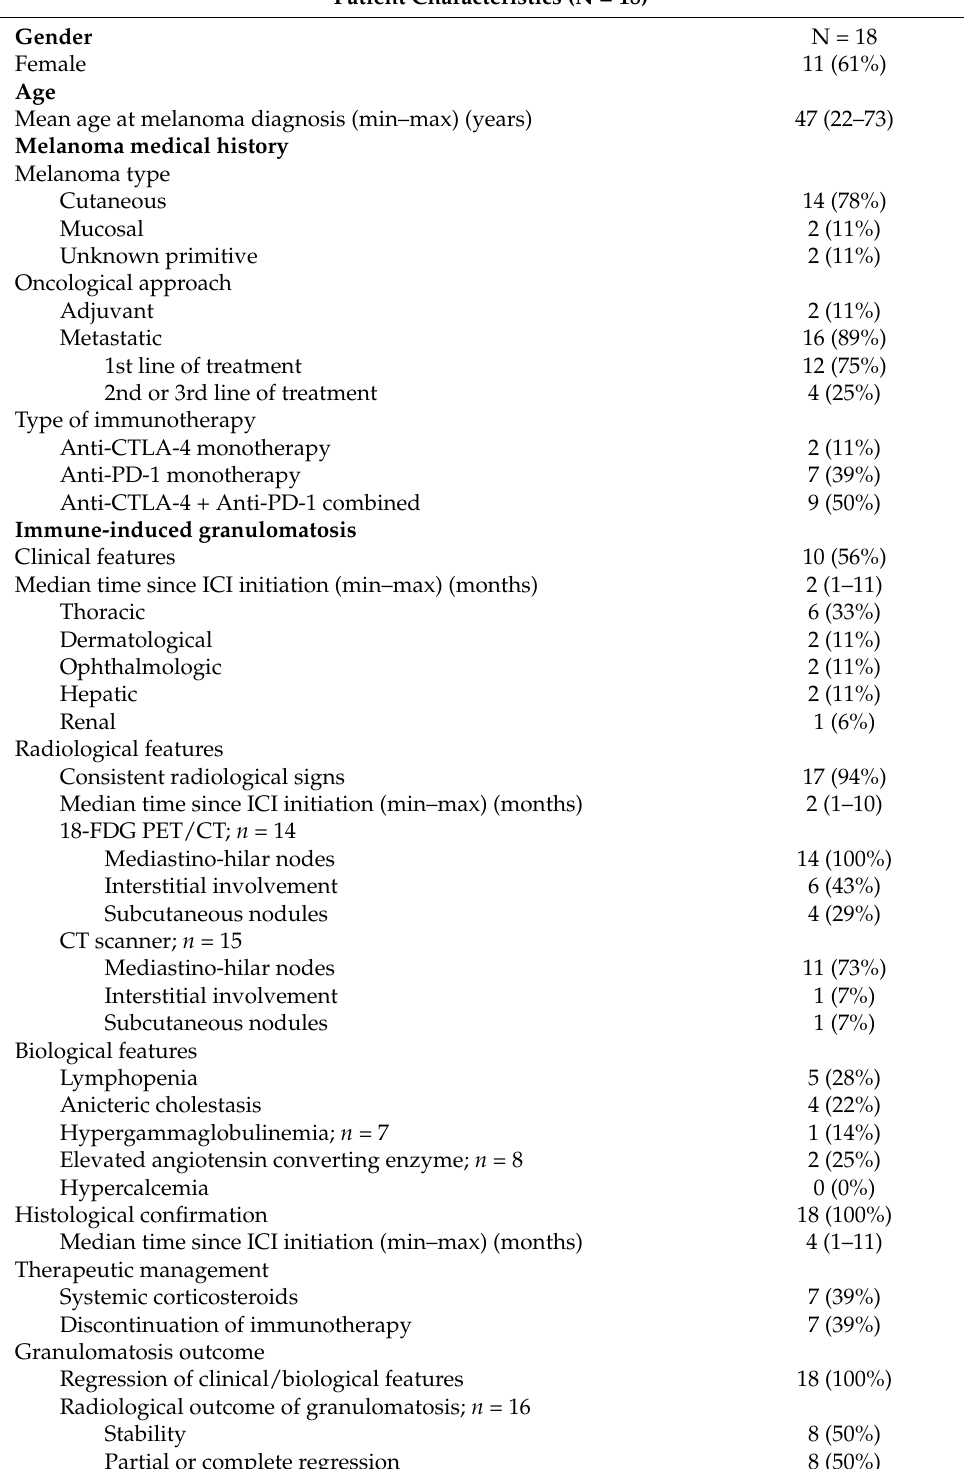
Table 1. Gustave Roussy’s patient